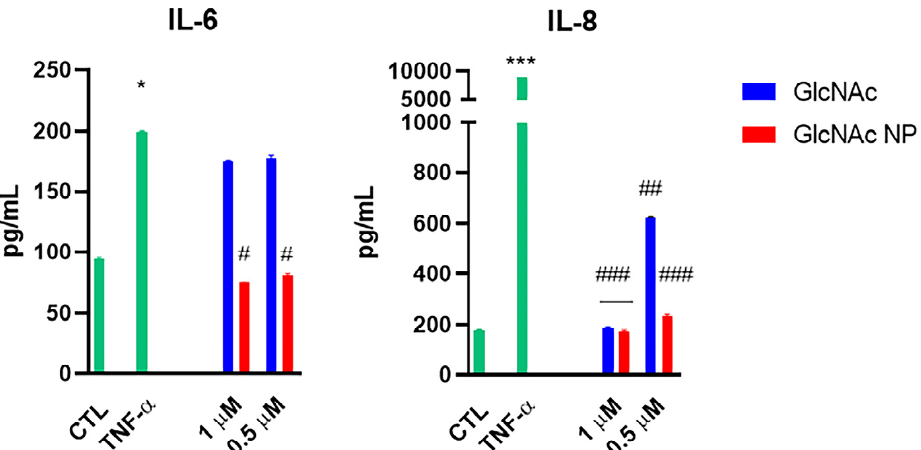
Figure 5. Effects of GlcNAc and GlcNAc NP on interleukins secretion in the culture medium under TNF- α stimulus. Cells were left untreated (CTL), stimulated with 10 ng/mL TNF- α for 30 min, or treated with two concentrations of GlcNAc and GlcNAc NP for 1 h and then stimulated with 10 ng/mL TNF- α for 1 h. After treatments, cell supernatants were collected and analysed by ELISA. The results are reported as pg/mL and are expressed as mean ± SD of data obtained by three independent experiments. * p < 0.05 and *** p < 0.005 vs. CTL; # p < 0.05, ## p < 0.01 and ### p < 0.005 vs. TNF- α .